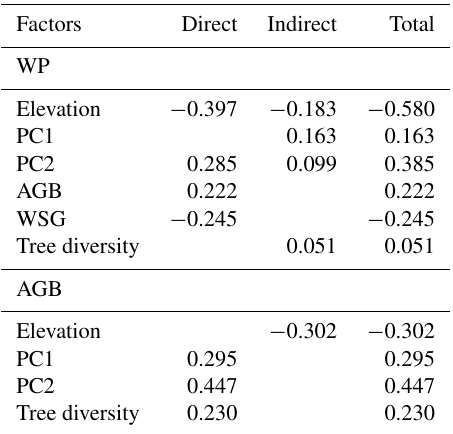
Table 1. Standardized direct, indirect and total effects of elevation, various stand structural parameters and soil chemical parameters on coarse-wood production (WP) and aboveground biomass (AGB) according to the SEM analysis in Fig. 4. Standardized path coeffi- cients are shown.